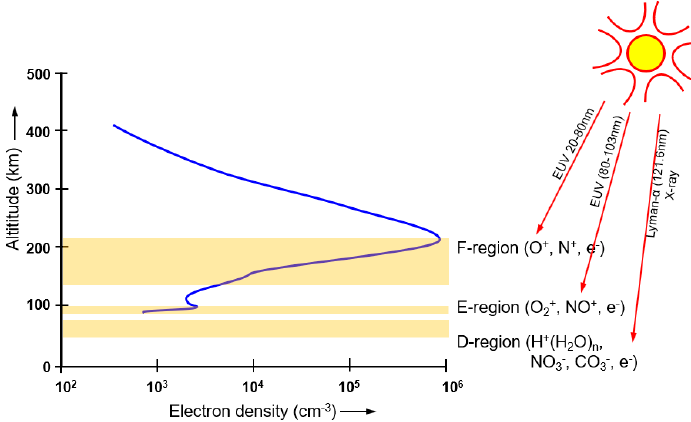
Figure 1. The ionosphere is a natural plasma, sustained by solar radiation [4].